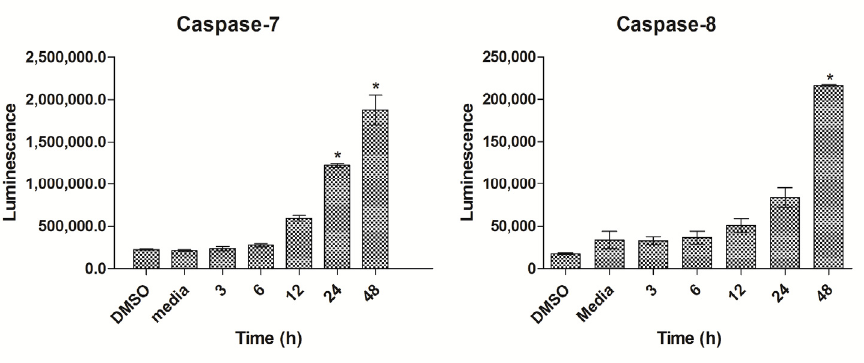
Figure 7. The luminescence assay demonstrated the activities of caspase-7, -8 and -9 on MCF7 cells treated with TPHE for 3, 6, 12, 24 and 48 h. The data are shown as the mean ± SD ( n = 3). * represents significant difference ( p < 0.05) compared with the